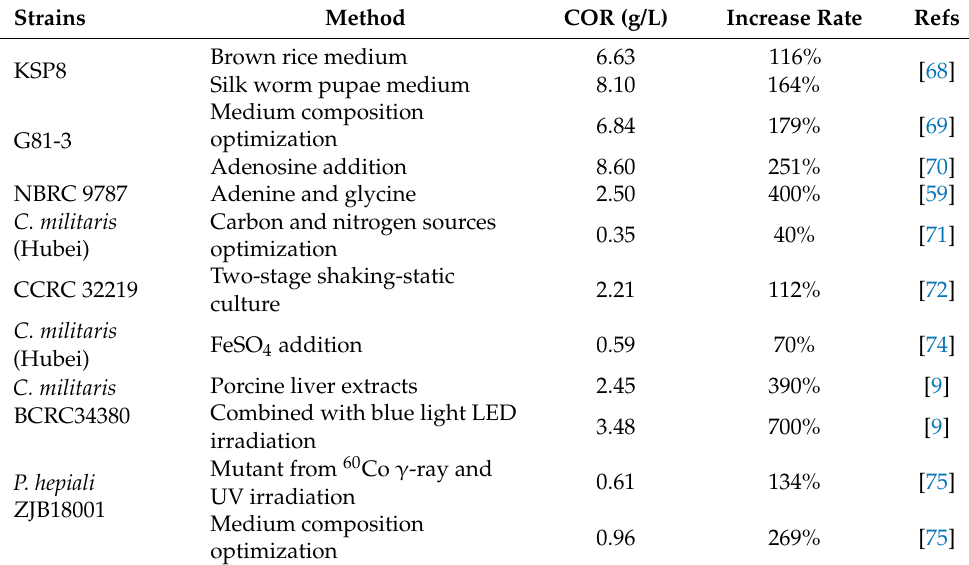
Table 2. Production of COR under different liquid fermentation